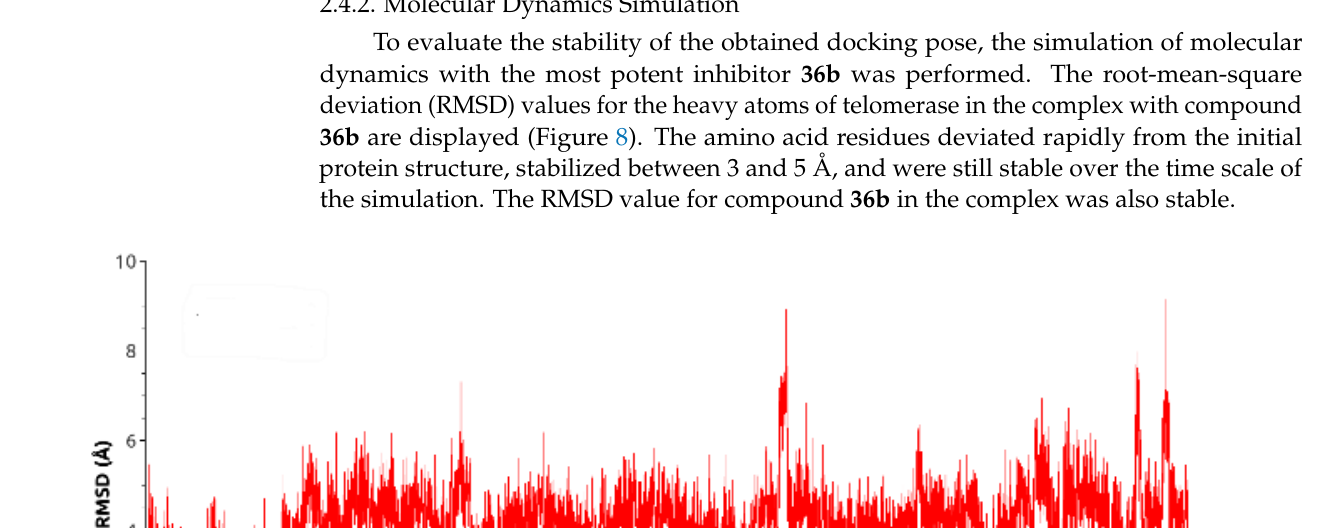
Figure 7. Position of compound 36b in the allosteric site of telomerase as predicted by molecular docking. ( a ) Structure of telomerase presented as molecular surface. ( b ) The main interaction of compound 36b with allosteric site. The H-bond is represented by the yellow line, π -cation interac- tion by the red dashed line, and hydrophobic interaction by the cyan dashed lines.